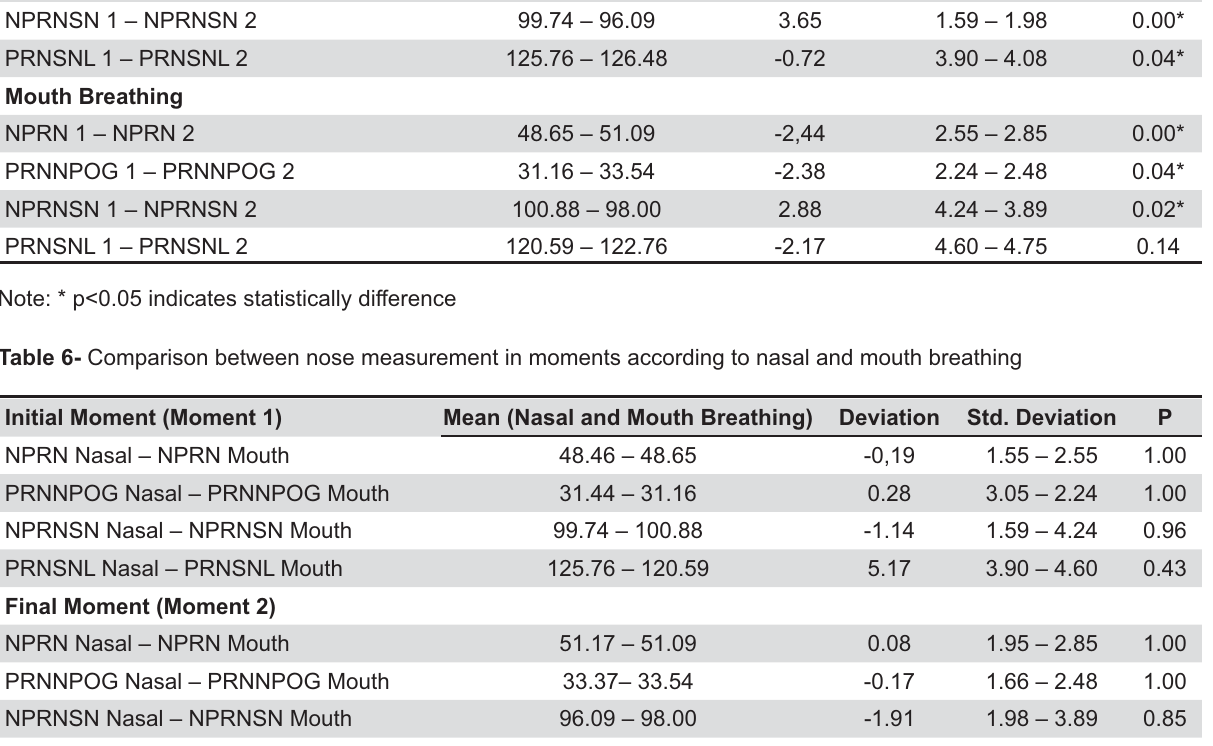
Note: * p<0.05 indicates statistically difference